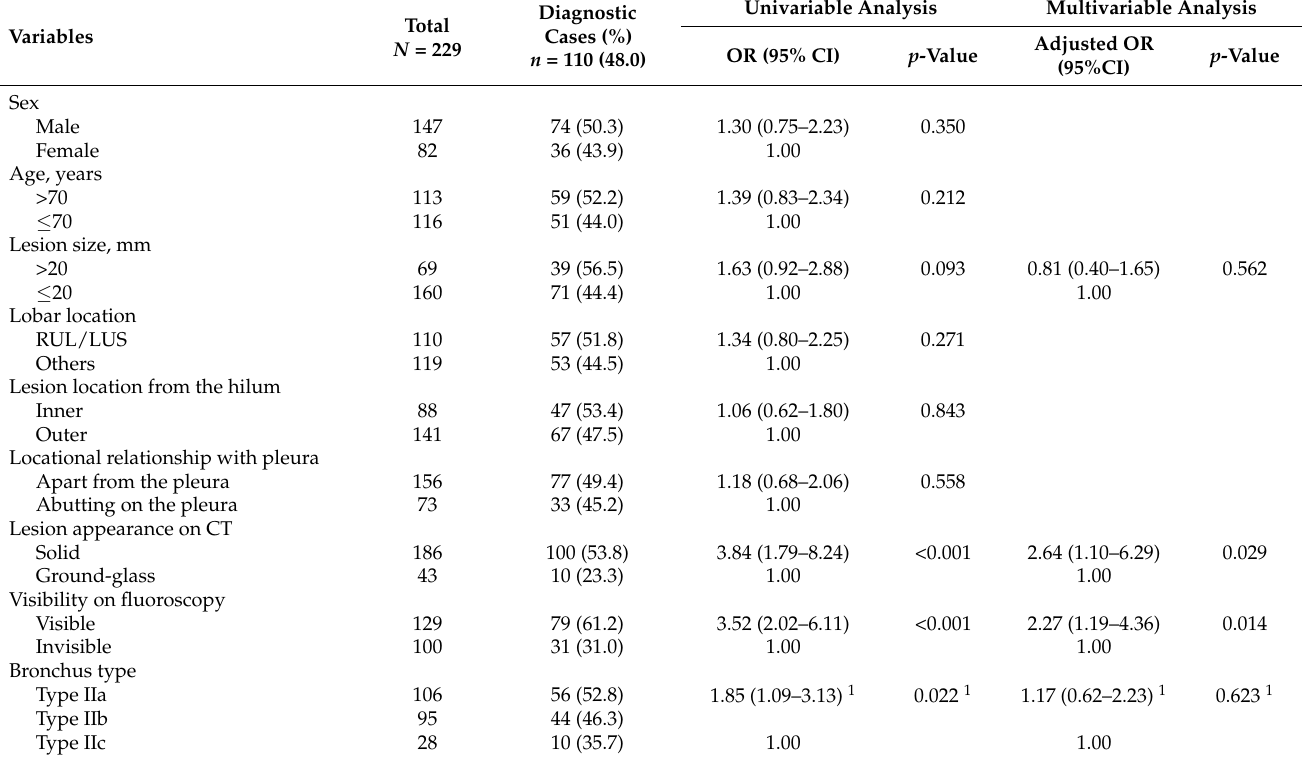
Table 5. Logistic regression analysis of factors affecting successful diagnosis in CT-BS group